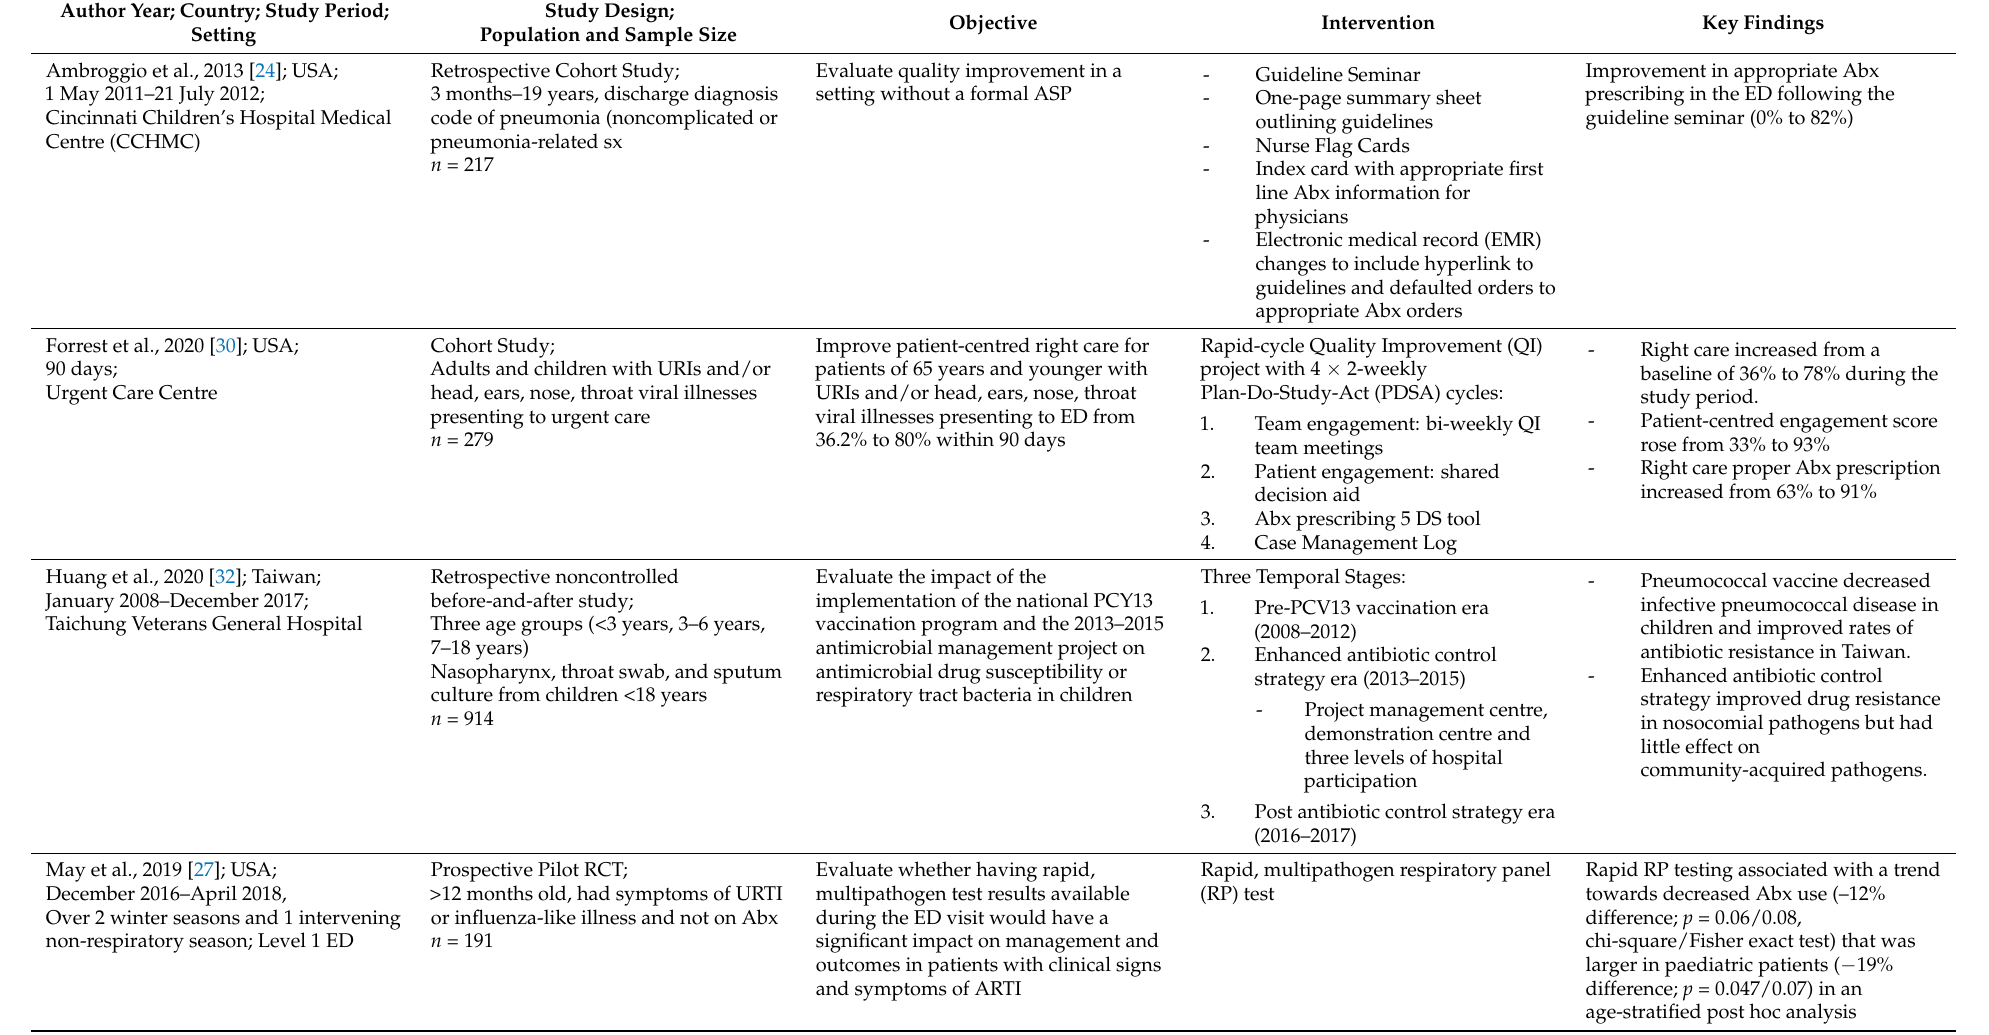
Table 1. Paediatric antimicrobial stewardship for respiratory infections in the emergency setting: a systematic review (1 August 2001 to 31 July